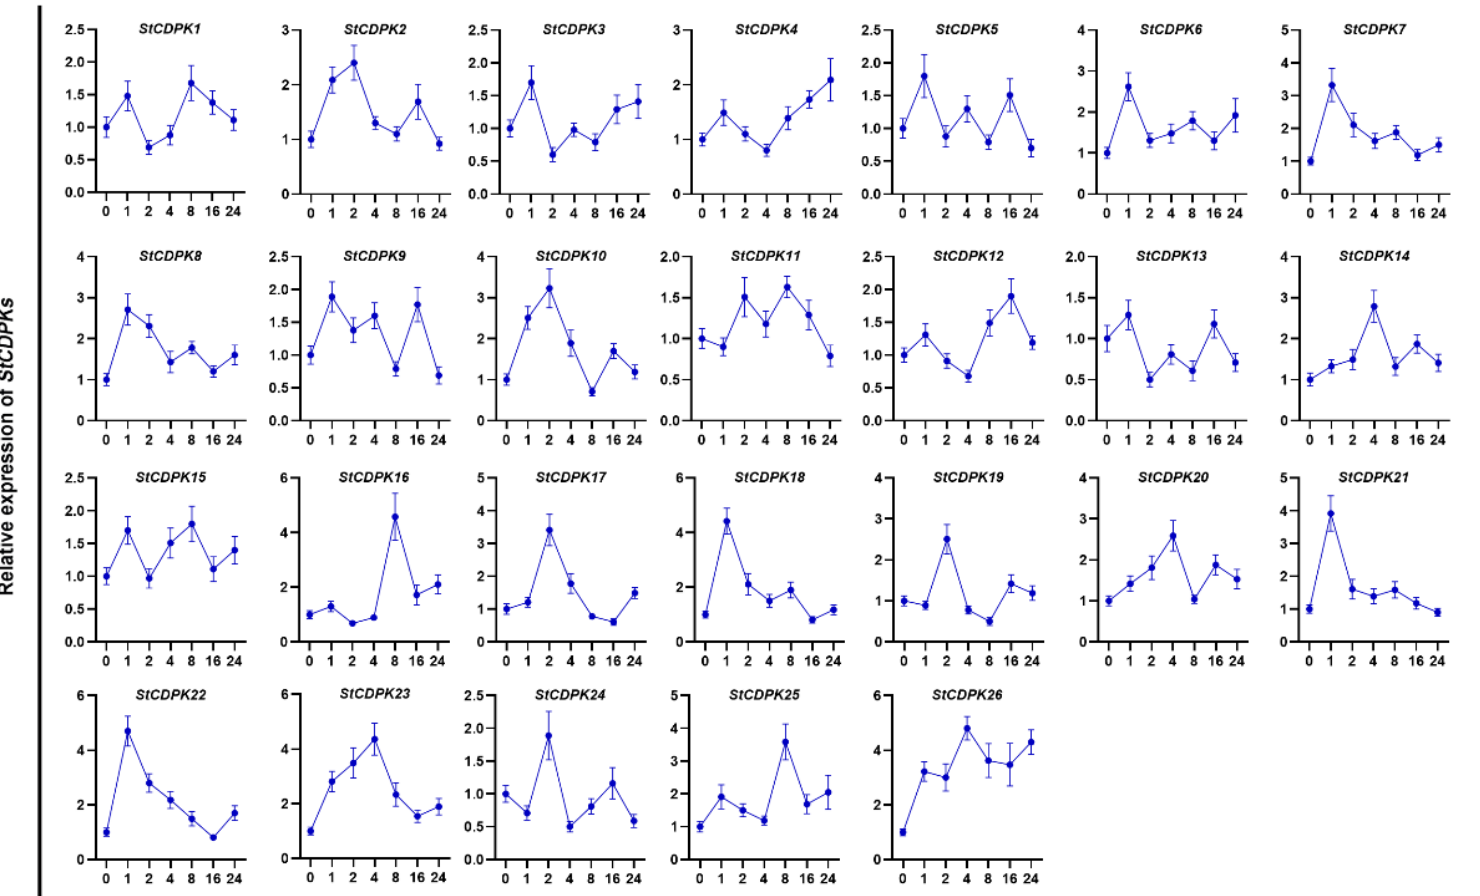
Figure 2. Expression profiles of StCDPKs in potato plants in response to 20% PEG6000. The mRNA expression of StCDPKs was relatively quantified by qRT-PCR and normalized to StEf1a . Data are presented as the means ± standard deviation of nine replicates.